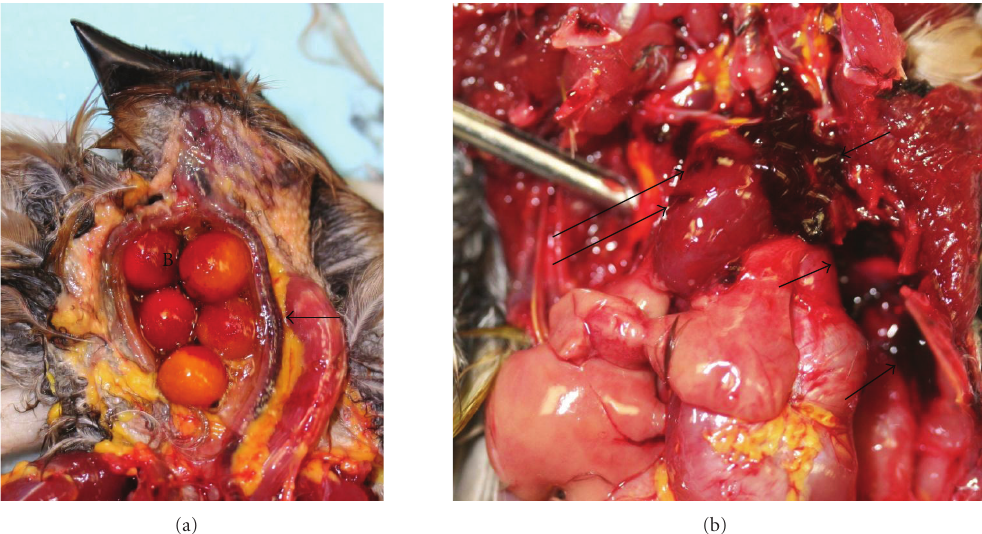
Figure 1: Toxicity of Nandina domestica in Cedar Waxwings. (a). Photograph showing berries of N. domestica (B) in a crop of dead Cedar Waxwing. The arrow shows congested and hemorrhagic trachea. (b). Photograph showing mediastinal and pulmonary (short arrows) and cardiac hemorrhages (long arrows).